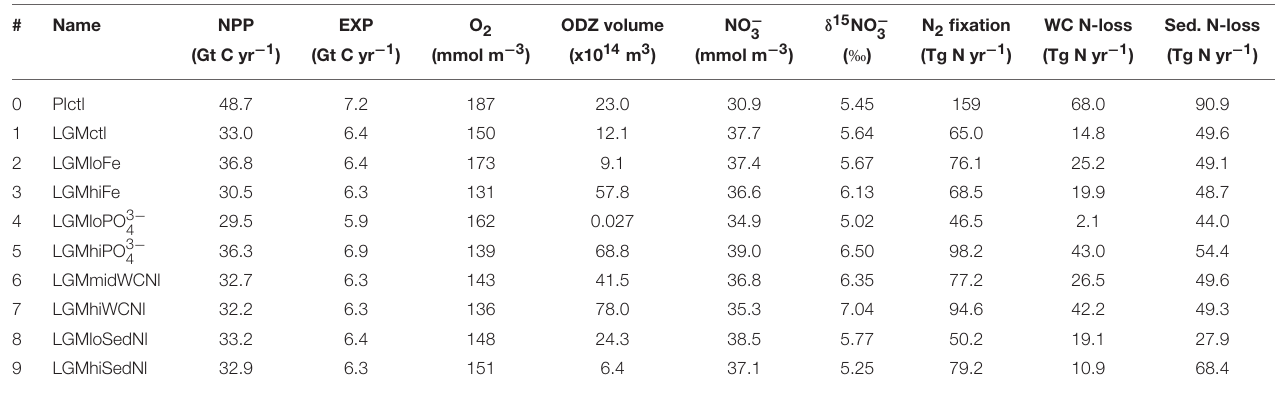
TABLE 2 | Global biogeochemical model